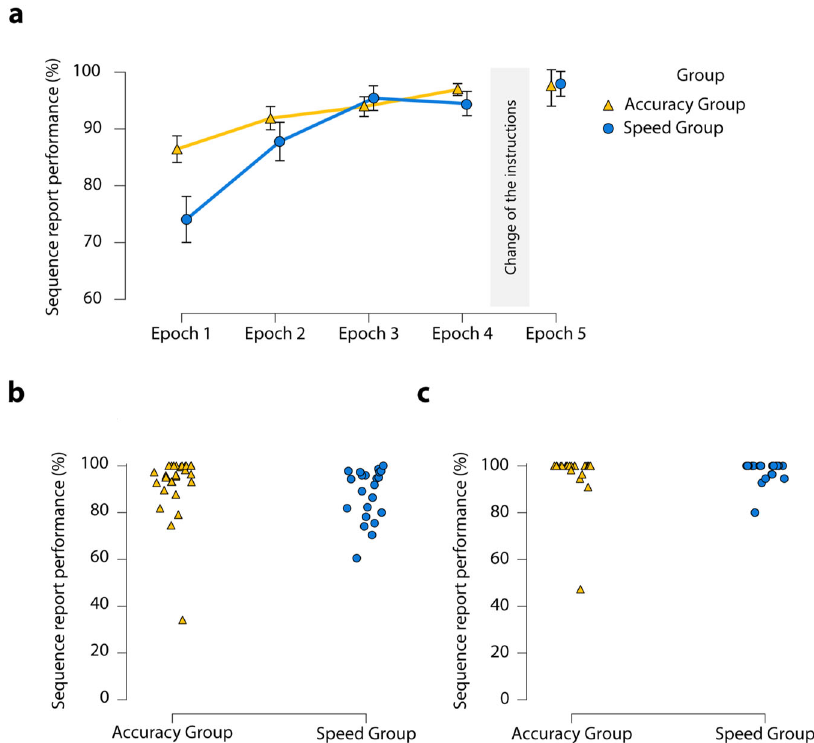
Fig. 3 Post-block sequence report performance. a Dynamics of post-block sequence report performance. The y -axis indicates the mean sequence report performance in percentage. The x -axis shows the epochs (Epoch 1 – 4: Different Instruction Phase, Epoch 5: Same Instruction Phase). The yellow line indicates the Accuracy Group, and the blue line the Speed Group. Both groups were able to report on the sequence. No signi fi cant group difference was found in either phase; however, on a trend-level, the Accuracy Group performed better in the fi rst epoch. The error bars represent standard error of the mean. b Individual data of the lack of signi fi cant main effect of Group of the main post-block sequence report performance in the Different Instruction Phase. Triangles and dots represent the individual data points. c Individual data of the lack of signi fi cant main effect of Group of the main post-block sequence report performance in the Same Instruction Phase. Triangles and dots represent the individual data